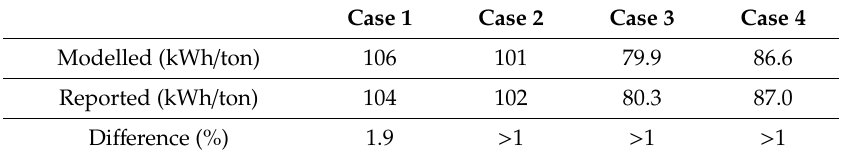
Table 2. Summary of the reported and modelled power consumptions for the “base” flow